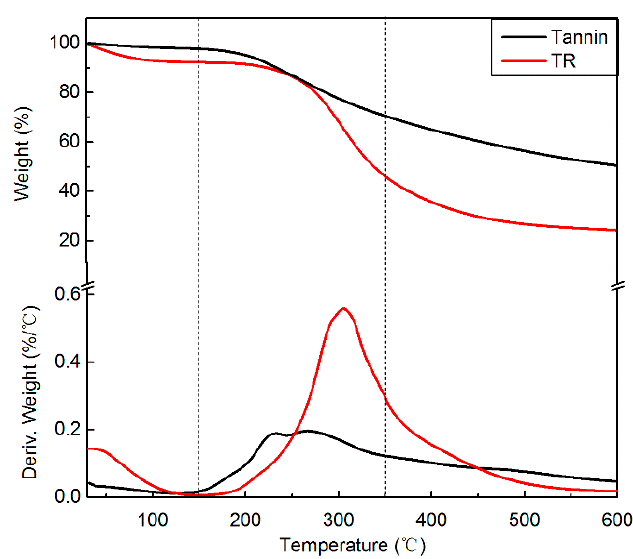
Figure 2. TG-DTG curves of tannin and TR.